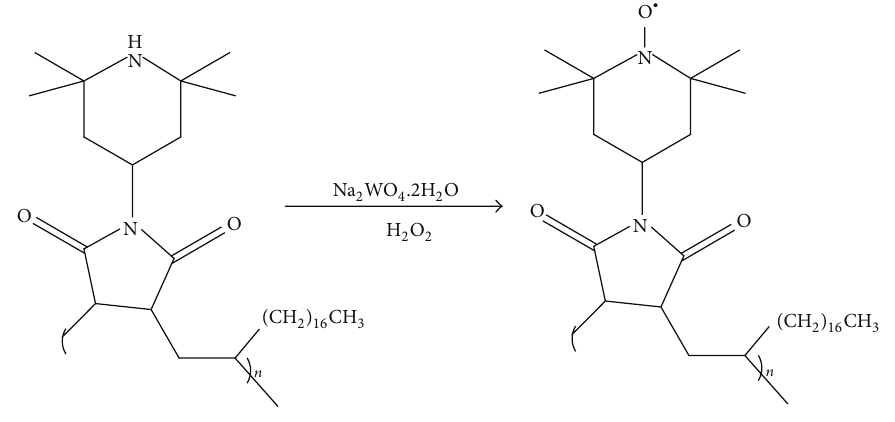
Figure 4: Synthesis of the organic radical